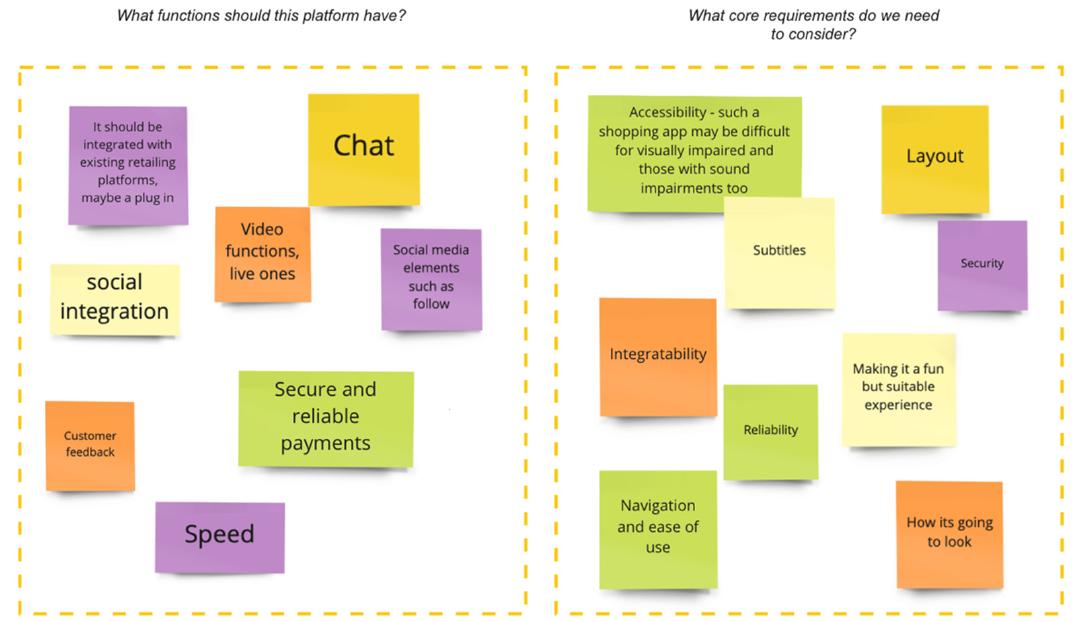
Figure 10. A screenshot from the Participatory Design Workshop Miro board, illustrating what core functions and requirements a live stream commerce platform should facilitate for its users.